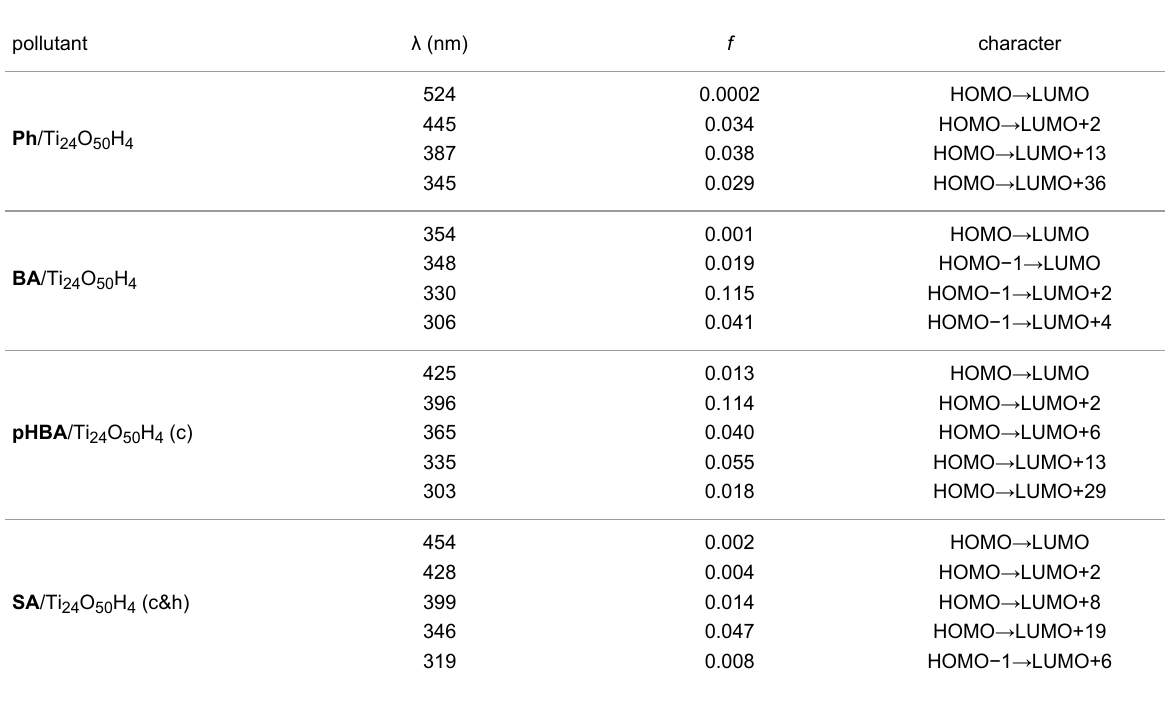
Table 4: Wavelength, oscillator strength and character of the most intense optical transition for the four pollutants adsorbed on the catalyst, calcu- lated at TD-DFT/B3LYP/DZVP level in water.